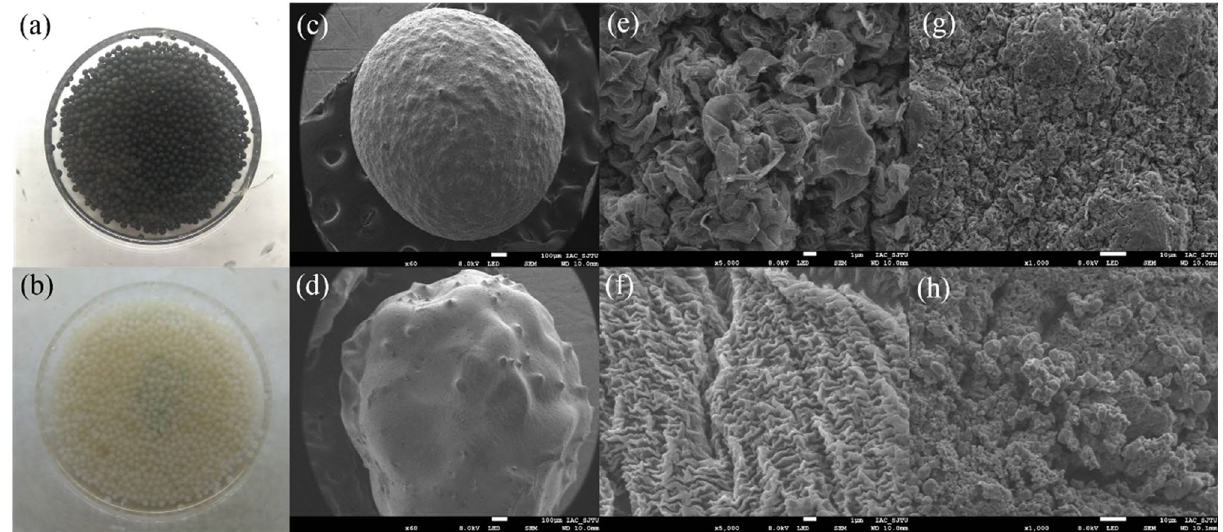
Figure 1. Photographs of ( a ) GAD and ( b ) SAS, ( c ), ( e ), and ( g ) are SEM images of GAD, ( d ) and ( f ) are SEM images of SAS; and ( h ) SEM images of GAD after a blue shift, with two characteristic peaks at 2926 cm −1 and 1415 cm −1 showing a red shift; one characteristic peak